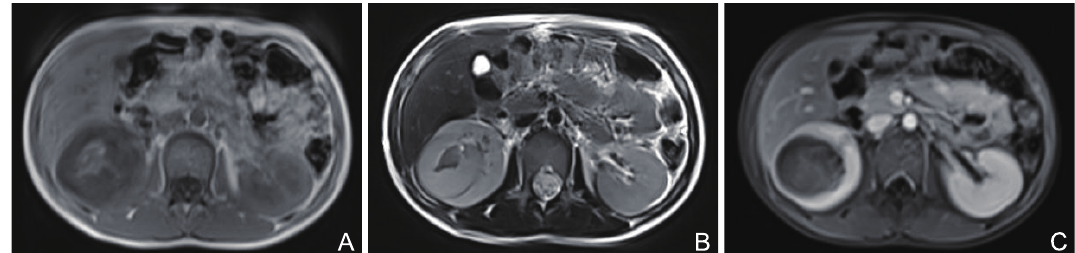
Figure 5 The abdominal MR scanning. (A~B) T1WI and T2WI of MR. On T1WI, the signal of the mass was uneven. Most of it was low signal and there were some high signal intensity areas inside it. On T1WI, most of the mass showed as equal signal intensity and there were some low signal intensity areas